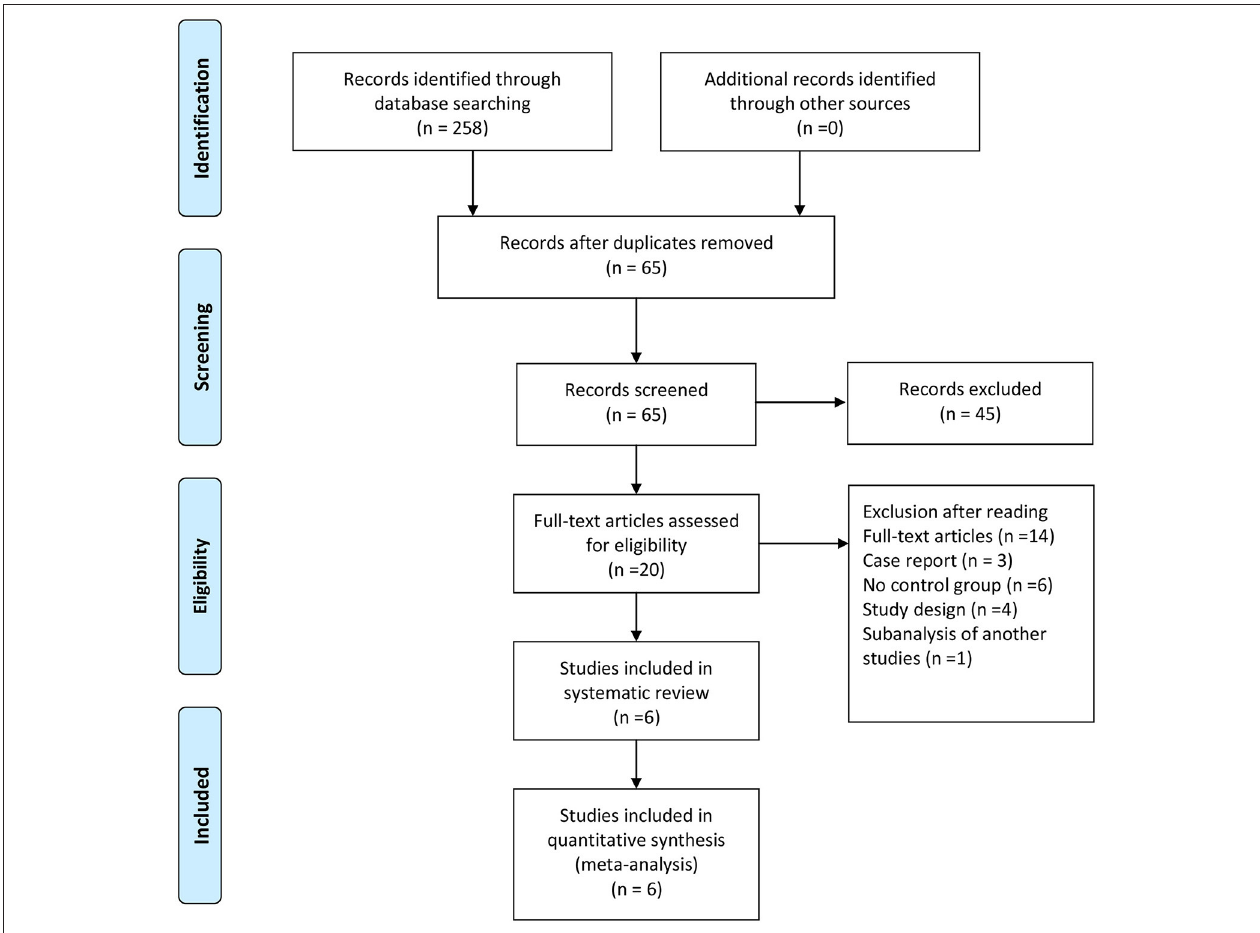
FIGURE 1 | Flow diagram for selection of studies (PRISMA flow